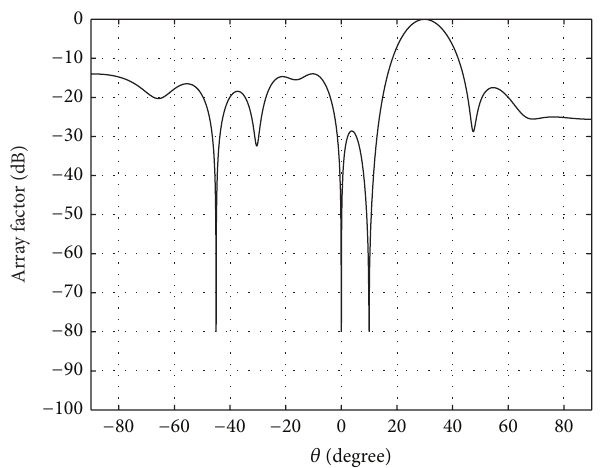
Figure 6: Resultant beam pattern designed ( 𝑁 = 10 ) by the feed- back function of (11) considering both element positions and com-